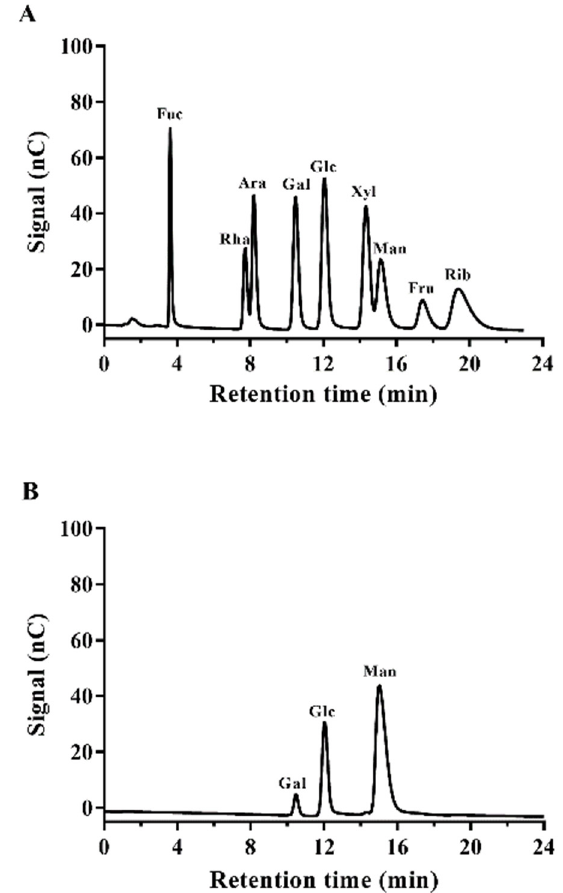
Figure 8. Gas chromatograms of the standard monosaccharides ( A ) and the EPS produced by Lpb. plantarum NMGL2 ( B ).